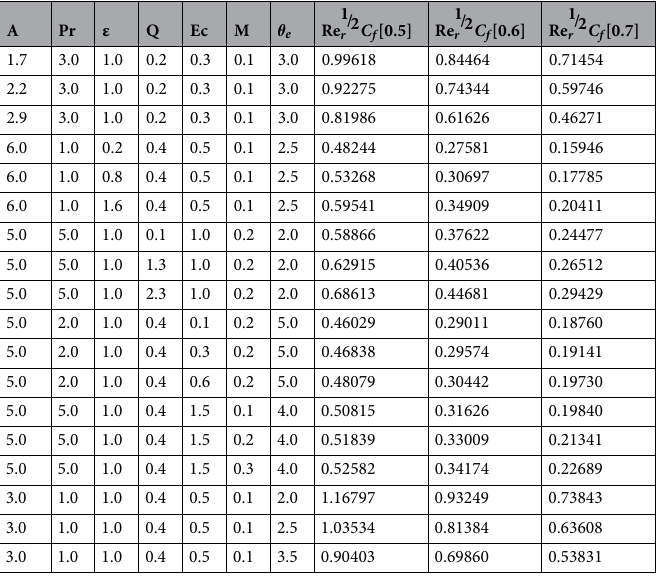
Re1 /2 r C f against several physical quantities.